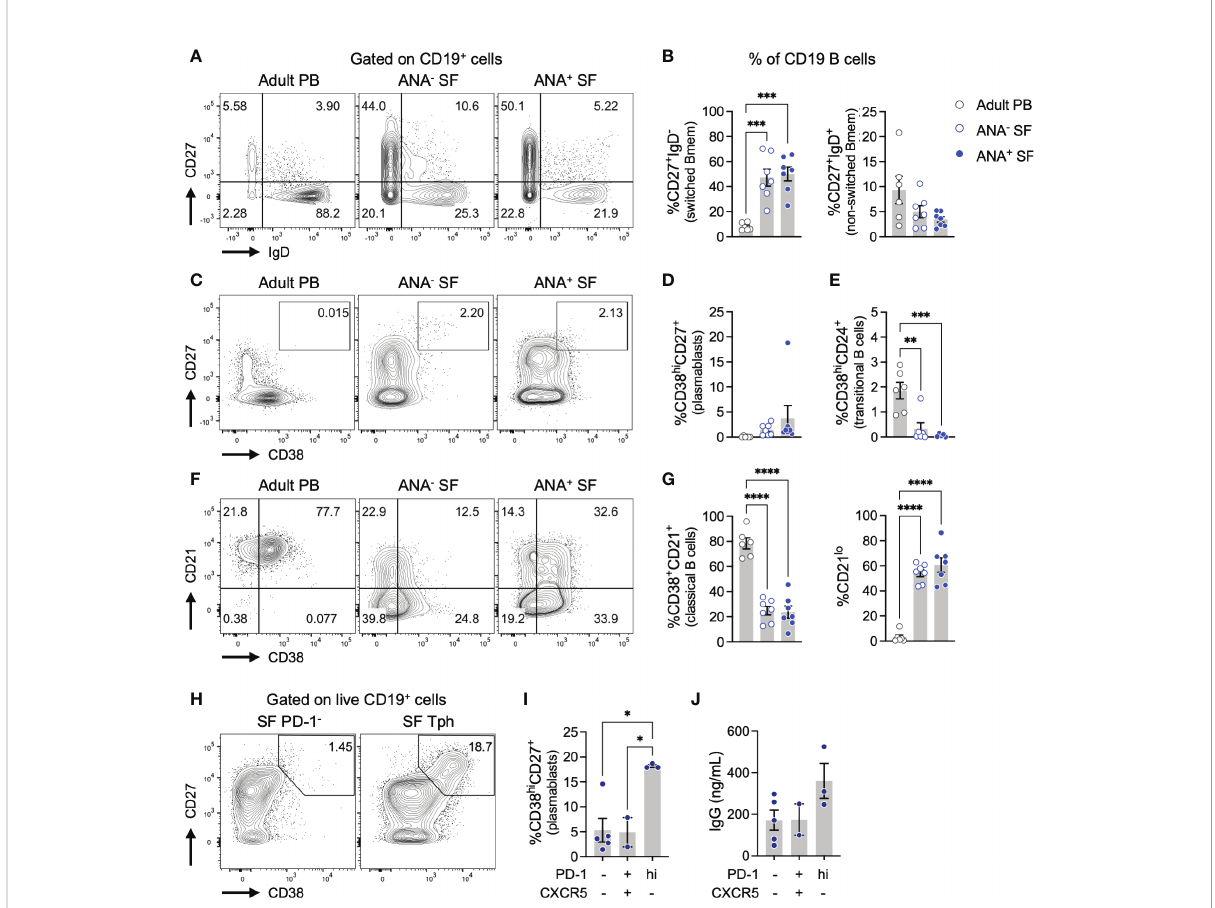
FIGURE 3 Tph cells in oligo JIA synovial fl uid promote the differentiation of memory B cells into plasmablasts. (A) Representative fl ow staining of memory B (Bmem) cell populations, gated on total CD19 + B cells. (B) Percent of switched (CD27 + IgD - ) and unswitched (CD27 + IgD + ) Bmem among CD19 + B cells in the SF of oligo JIA patients (ANA - : n=7, ANA + : n=7, blue circles) and in the PB of adult controls (n=6, black circles). (C) Representative fl ow staining of CD38 hi CD27 + plasmablasts, gated on total CD19 + B cells. (D) Percent of plasmablasts (CD38 hi CD27 + ) among CD19 + B cells in the SF of oligo JIA patients (ANA - : n=7, ANA + : n=7) and in the PB of adult controls (n=6). (E) Percent of transitional B cells (CD38 hi CD24 + ) among CD19 + B cells in the SF of oligo JIA patients (ANA - : n=7, ANA + : n=7) and in the PB of adult controls (n=6). (F) Representative fl ow staining of classical and CD21 lo B cell populations, gated on total CD19 + B cells. (G) Percent of classical (CD38 + CD21 + ) and CD21 lo B cells among CD19 + B cells in the SF of oligo JIA patients (ANA - : n=7, ANA + : n=7), and in the PB of adult controls (n=6). (H) Representative staining of a co-culture of the indicated population of oligo JIA SF CD4 + T cells with PB Bmem cells from a third party control after 5 days of incubation in the presence of SEB (1 m g/mL), gated on total CD19 + B cells. (I) Percent of plasmablasts (CD38 hi CD27 + ) among CD19 + B cells in co-cultures with the corresponding SF CD4 + T cell population (3 independent experiments). (J) Concentration of IgG detected in the supernatant of B cell co-cultured with the corresponding SF CD4 + T cell population (3 independent experiments). Oligo JIA, oligoarticular juvenile idiopathic arthritis; PB, peripheral blood; SF, synovial fl uid; ANA, antinuclear antibody; Tph, T peripheral helper cell; SEB, staphylococcal enterotoxin (B) Summary data on bar graphs are mean ± standard error. P-value <0.05 (*); <0.01 (**), <0.001 (***), <0.0001 (****). Statistical testing: one-way ANOVA followed by multiple t-tests with Turkey